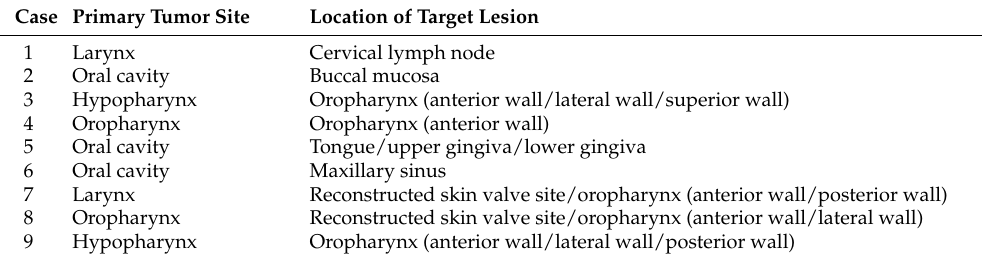
Table 2. Location of target lesion.